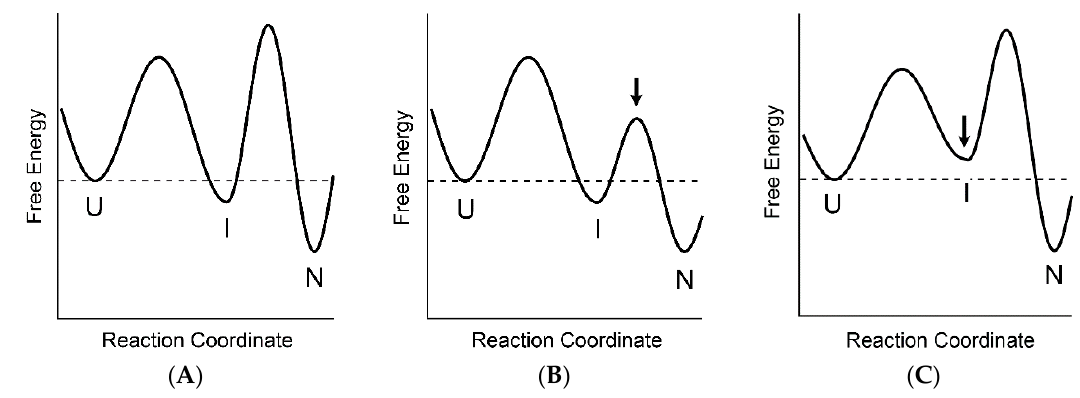
Figure 6. The free-energy profiles of the non-two-state and the two-state folding reactions. ( A ) Hierarchical three-state folding, ( B ) two-state folding in the first scenario, and ( C ) two-state folding in the second scenario. The horizontal broken line in each panel shows the free-energy level of U. Arrows in panel ( B ) and ( C ) indicate the places where the free-energy level has been changes as compared with the level in panel ( A ).